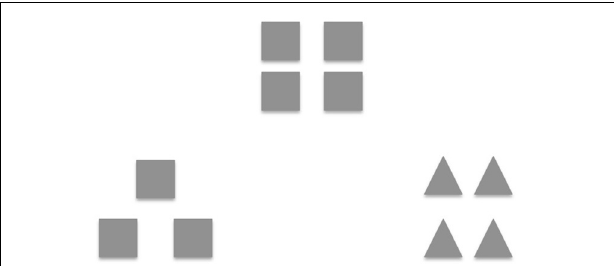
FIGURE 1 | Global-local task. One item from the global-local shape task [adapted with permission from Kimchi and Palmer (1982)]. Participants had to indicate which one of two sample figures most resembled the target figure (i.e., square made of squares). Each figure was either a square or a triangle (global feature) made up of smaller squares or triangles (local